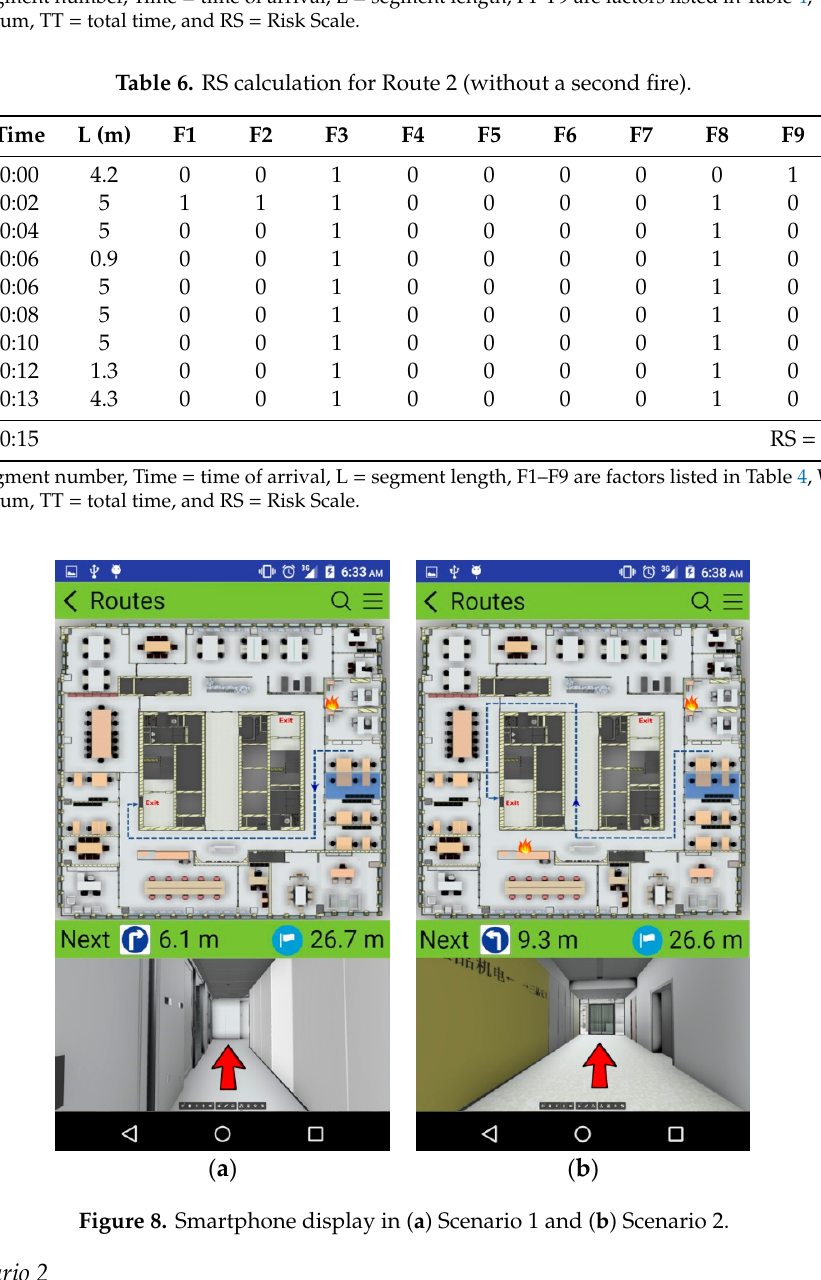
174.21 S. No = segment number, Time = time of arrival, L = segment length, F1–F9 are factors listed in Table 4, W. Sum = weighted sum, TT = total time, and RS = Risk Scale.